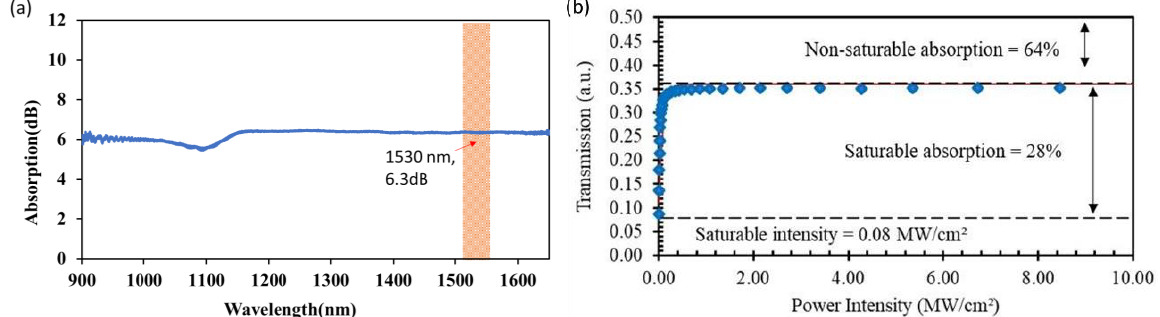
Figure 3. ( a ) Linear absorption of the fabricated Nb 2 AlC film with vertical bar at 1530 nm for the operating wavelength ( b ) Nonlinear absorption spectrum of MAX-PVA.